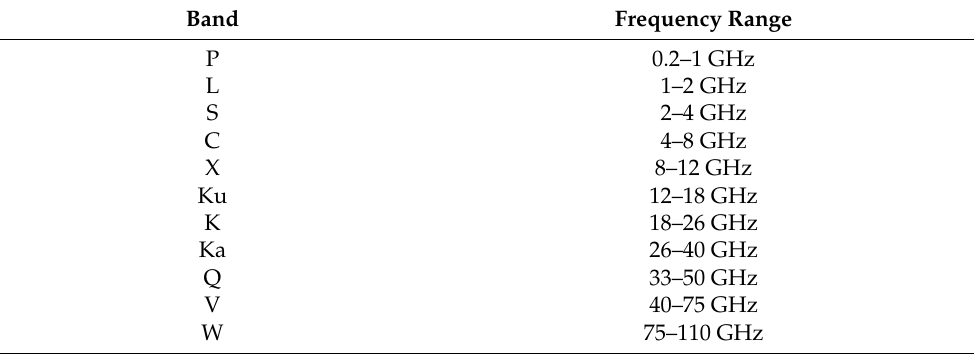
Table 2. Satellite spectrum